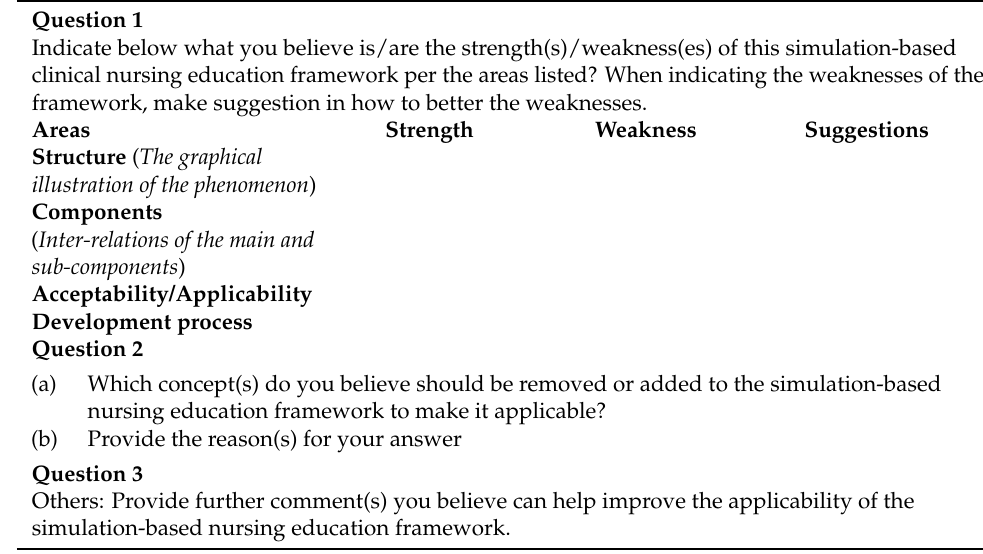
Table 2. Nominal group discussion